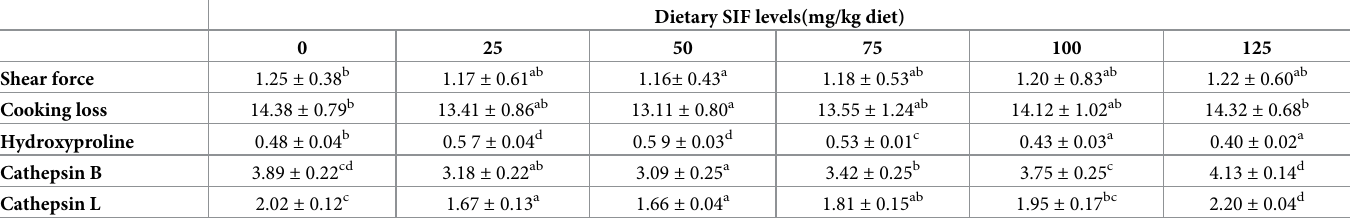
Table 6. Muscle shear force (N), cooking loss (%), hydroxyproline concentration (mg/g tissue) and cathepsin B and L activities (U/g muscle) of grass carp fed diets with graded levels of SIF (mg/kg) 1 .